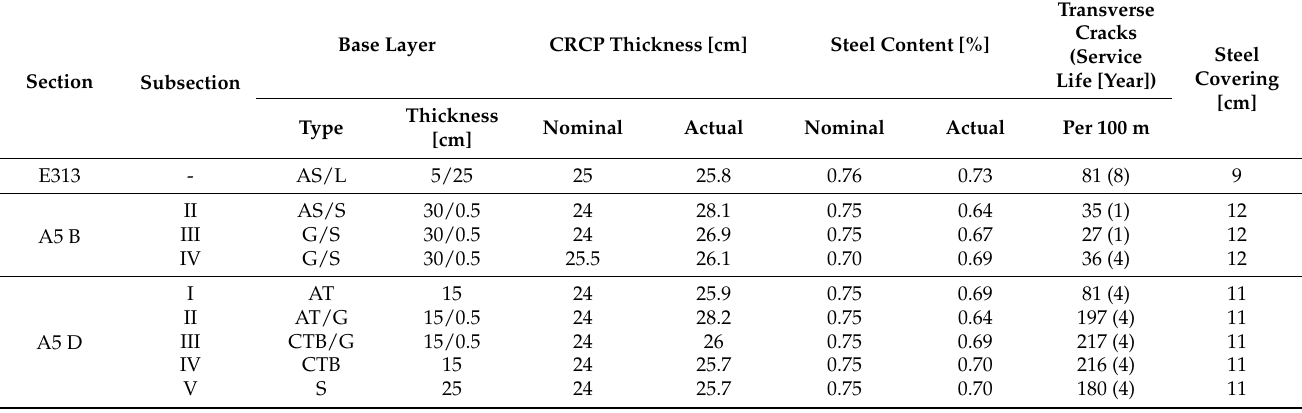
Table 1. Technical data of investigated tracks. AS: asphalt interlayer, L: lean concrete, S: cement stabilization, G: geotextile, AT: asphalt base course, CTB: cement-treated